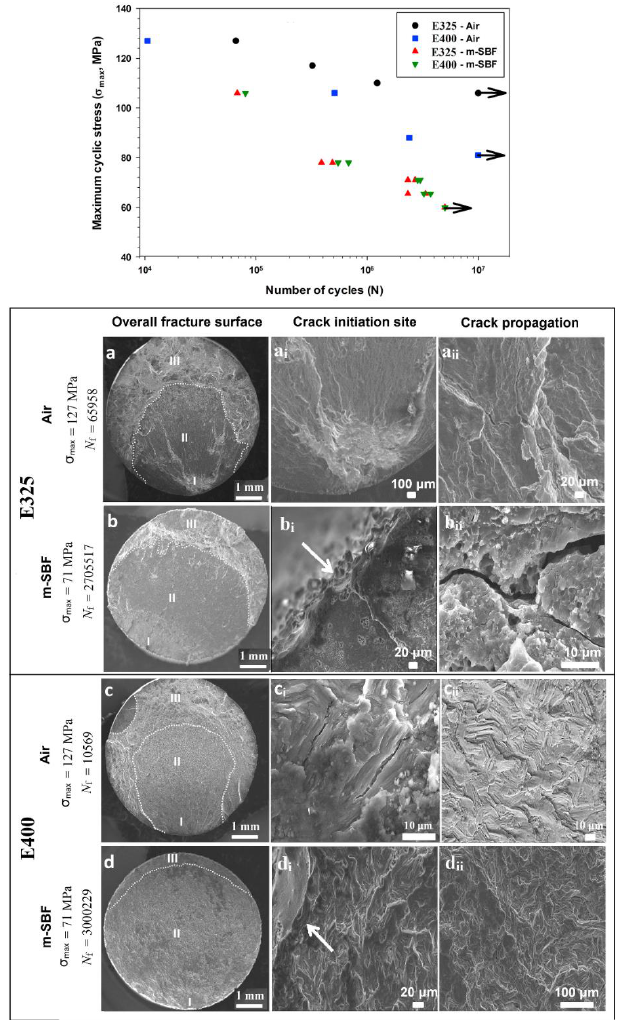
Figure 28. Top: S-N fatigue curves for E325 and E400 Mg alloys tested in air and m-SBF. Arrows correspond to run-out samples. Bottom: SEM fractographs: ( a ) E325 tested in air, ( b ) E325 tested in m-SBF, ( c ) E400 tested in air, ( d ) E400 tested in m-SBF. σ max is the maximum applied stress amplitude and N f is the number of cycles to failure. The arrows in b i and d i indicate locations of crack nucleation [324]. Reprinted with permission from